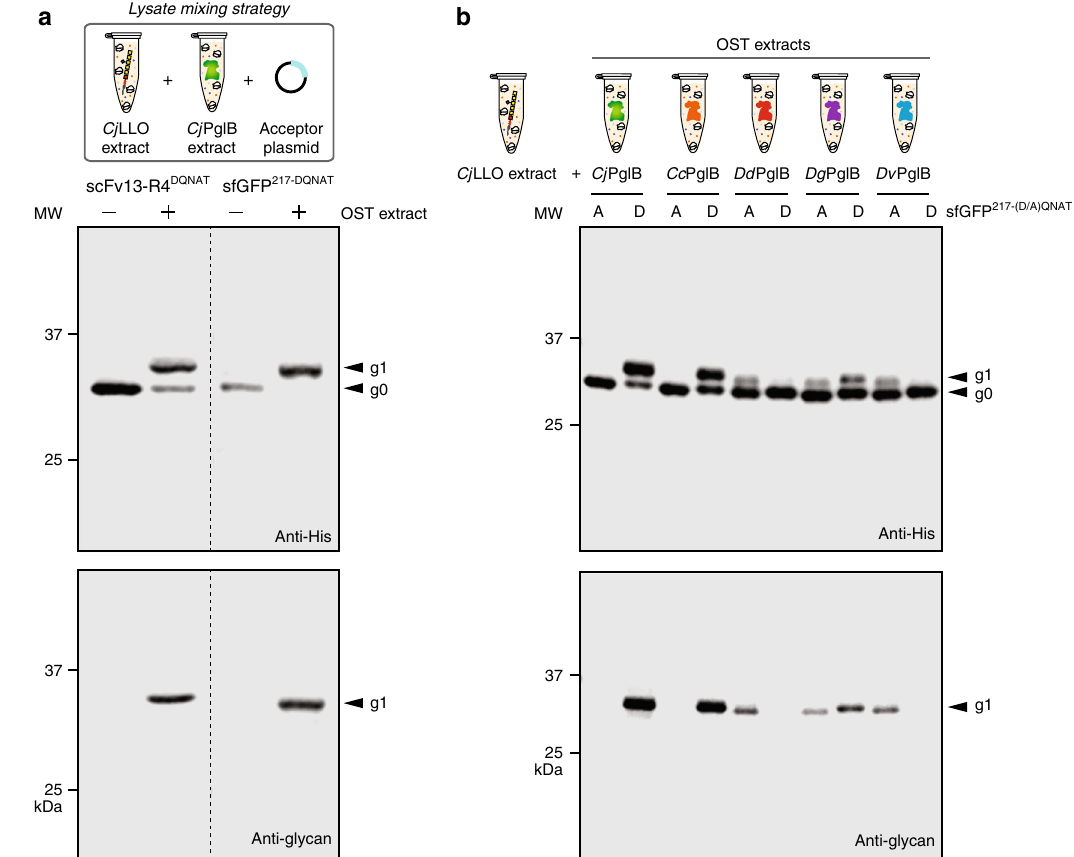
Fig. 4 Mixing of CFGpS extracts enables rapid prototyping of different OST enzymes. a Western blot analysis of CFGpS reactions performed using lysate mixing strategy whereby Cj LLO lysate derived from CLM24 cells carrying pMW07-pgl Δ B was mixed with Cj PglB lysate derived from CLM24 cells carrying pSF- Cj PglB, and the resulting CFGpS mixture was primed with plasmid DNA encoding either scFv13-R4 DQNAT or sfGFP 217-DQNAT . b Western blot analysis of CFGpS reactions performed using Cj LLO lysate mixed with extract derived from CLM24 cells carrying a pSF plasmid encoding one of the following OSTs: Cj PglB, Cc PglB, Dd PglB, Dg PglB, or Dv PglB. Mixed lysates were primed with plasmid DNA encoding either sfGFP 217-DQNAT (D) or sfGFP 217-AQNAT (A).